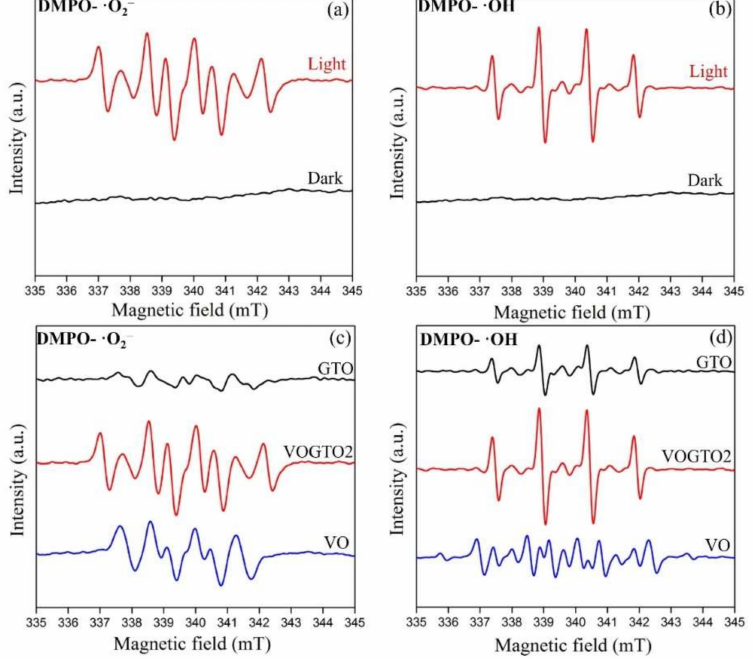
Figure 5. DMPO spin-trapping ESR spectra of VOGTO2 for ( a ) · O 2 − in methanol dispersion and ( b ) · OH in water dispersion; The ESR signal intensity of VO, GTO and VOGTO2 for ( c ) O 2 − in methanol dispersion and for ( d ) · OH in water